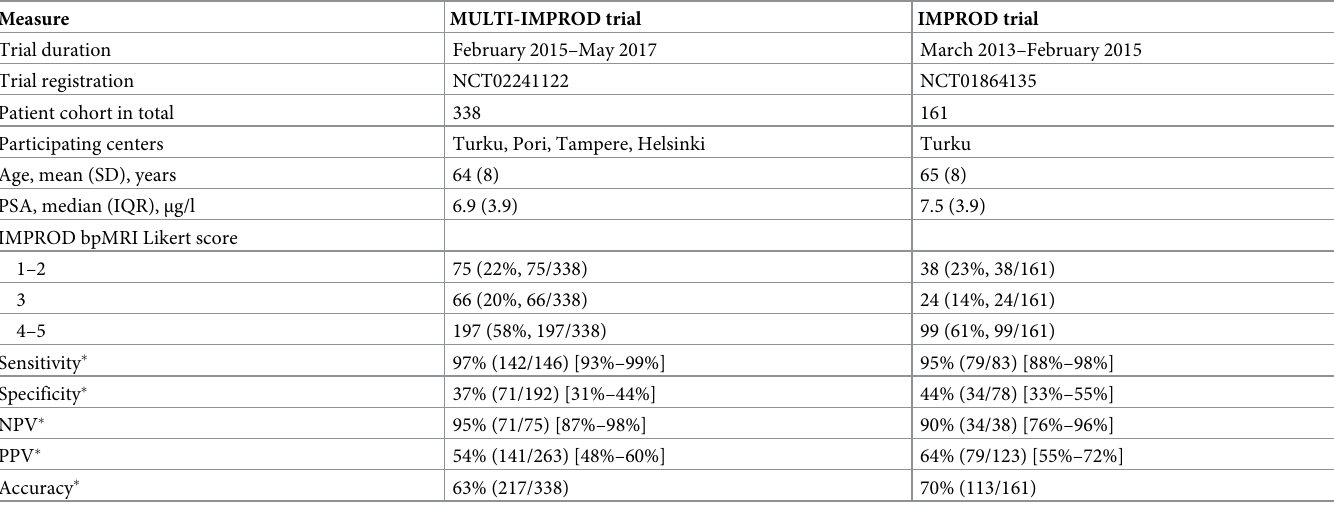
Table 3. Comparison between the current trial (MULTI-IMPROD trial) and the pre-validation cohort (IMPROD trial).